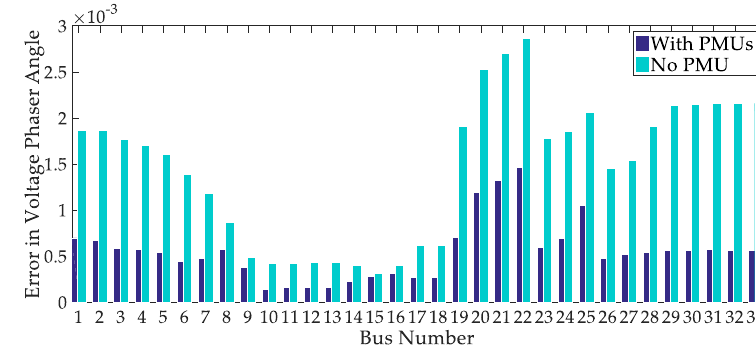
Figure 6. Comparison of error in voltage phase angle estimation. Table 2. Comparison of optimal solutions in IEEE Standard Bus